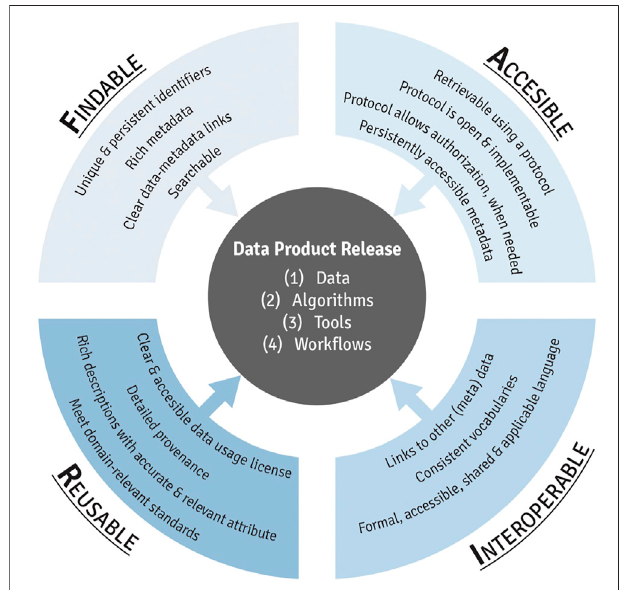
FIGURE 2 | An overview of the individual components of FAIR data managementpractices,resultingintheeffective releaseofdataproductsfrom exposure science, epidemiology, toxicology, and environmental health